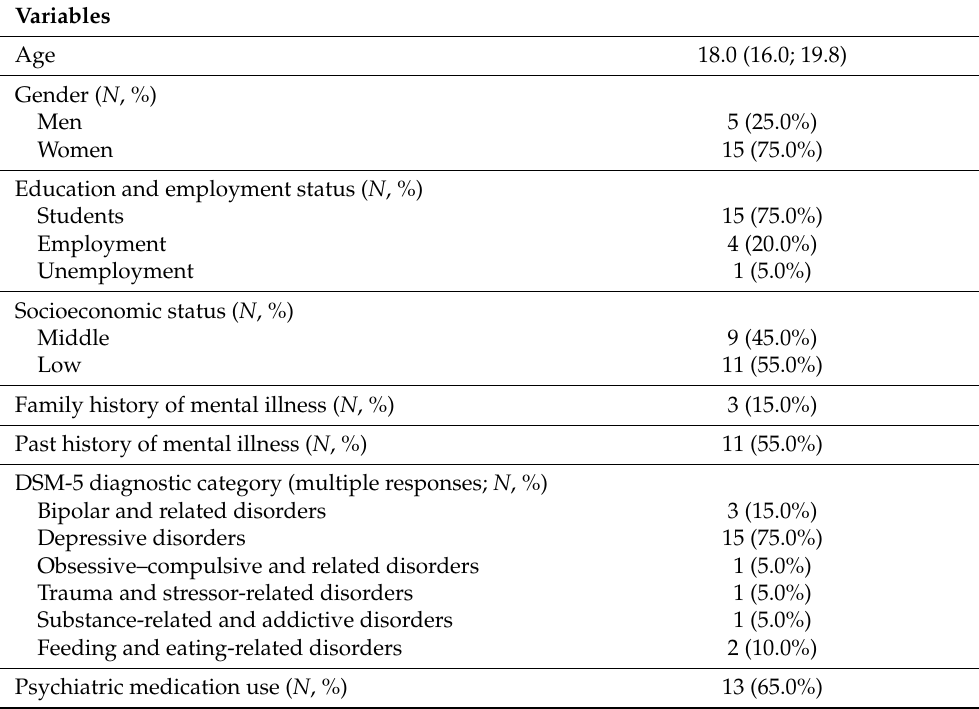
Table 1. Sociodemographic and clinical characteristics ( N =